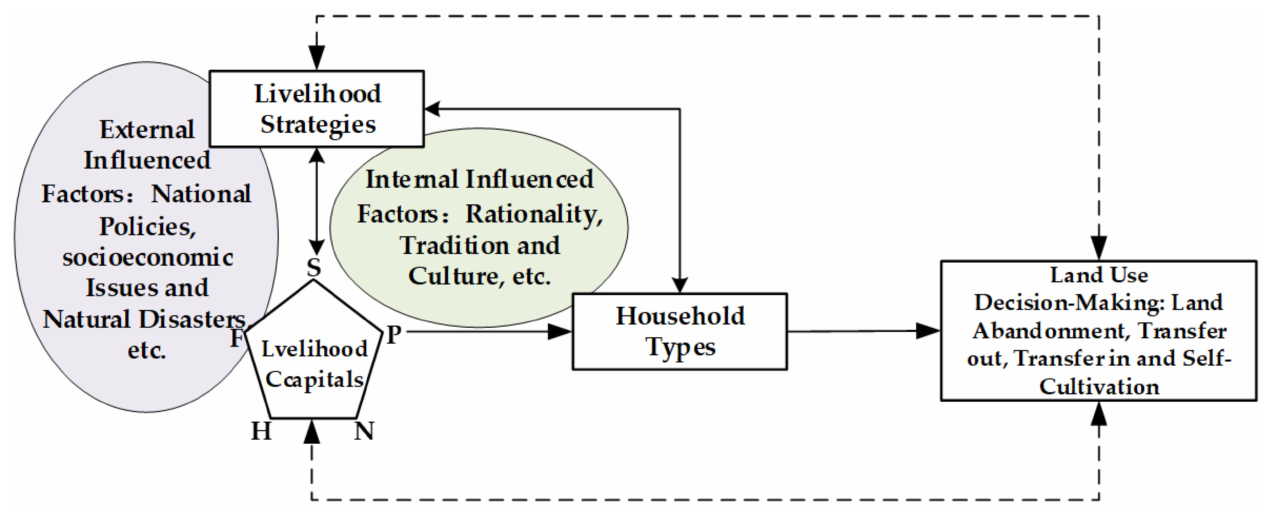
Figure 1. Framework for household land use decision-making based on the